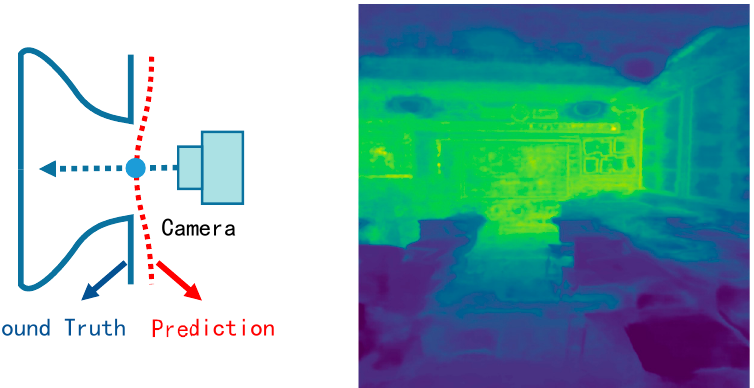
Figure 2. Geometric structure constructed by NeRF with a small number of input images (first from left) and the visualized depth information (second from left).